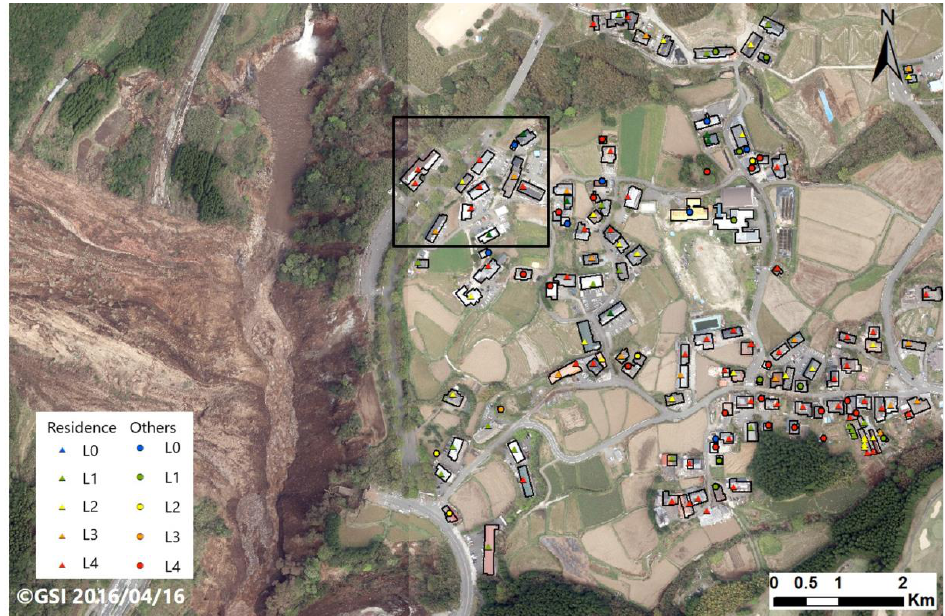
Figure 10. Orthorectified aerial photo of Kawayo district, taken by GSI on 2016/04/16, with building footprints and damage classification provided by the local government. The triangular damage level symbols indicate residential buildings, while the circular symbols indicate non-residential buildings. Table 2. Earthquake loss evaluation classes of buildings used by local governments in Japan and schematic images of other damage classification methods [38].